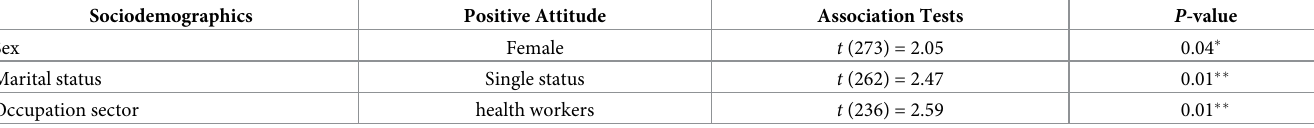
Table 4. Significant association between sociodemographics and attitude toward dietary supplements.